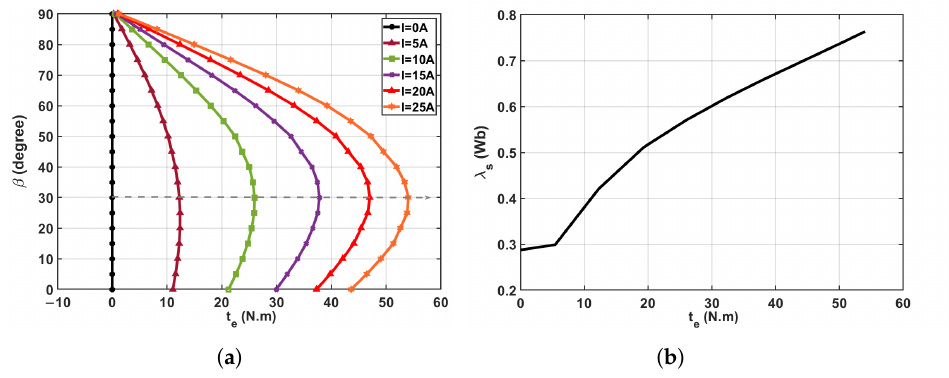
Figure 4. The MTPA profile of the driven PMSM: ( a ) In FOC drives and ( b ) In DTC drives.